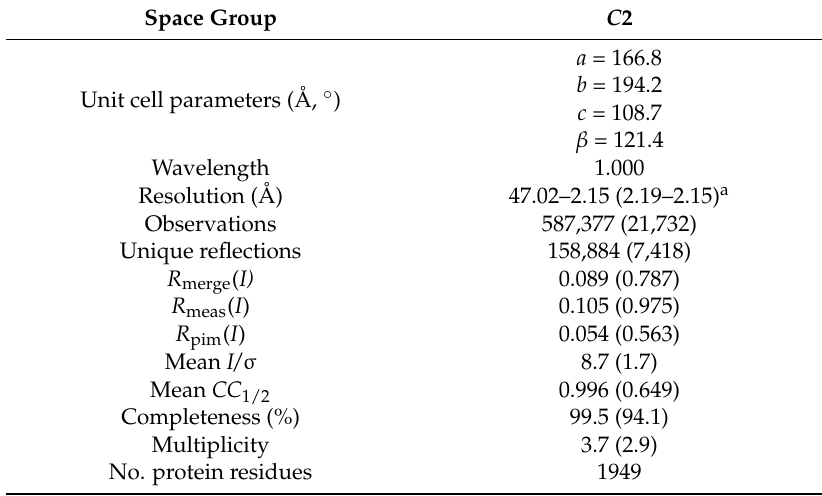
Table 1. Data collection and refinement statistics.